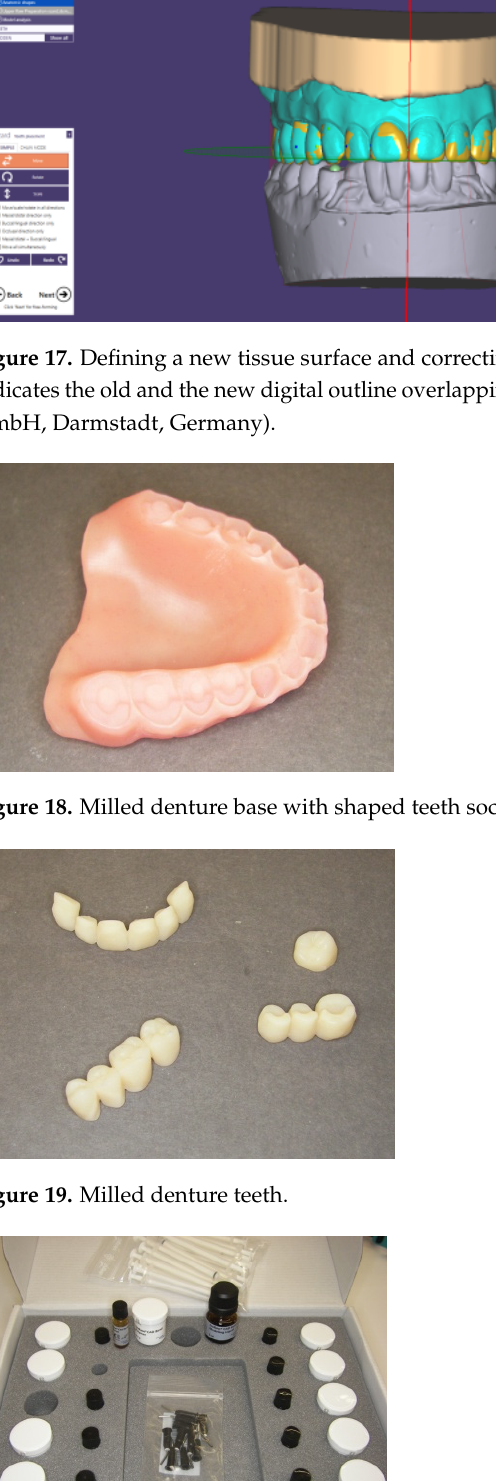
Figure 20. Digital denture teeth bonding kit.